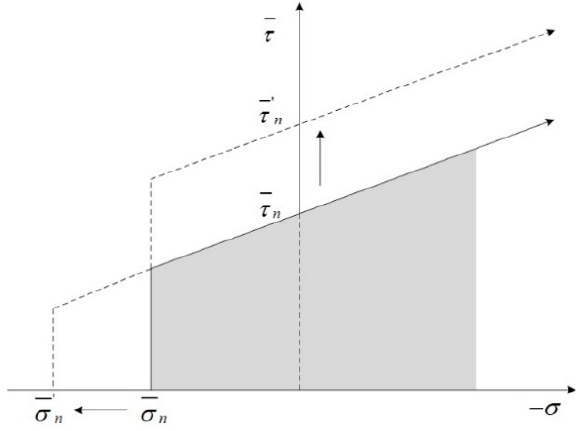
Figure 17. Change in bond strength.